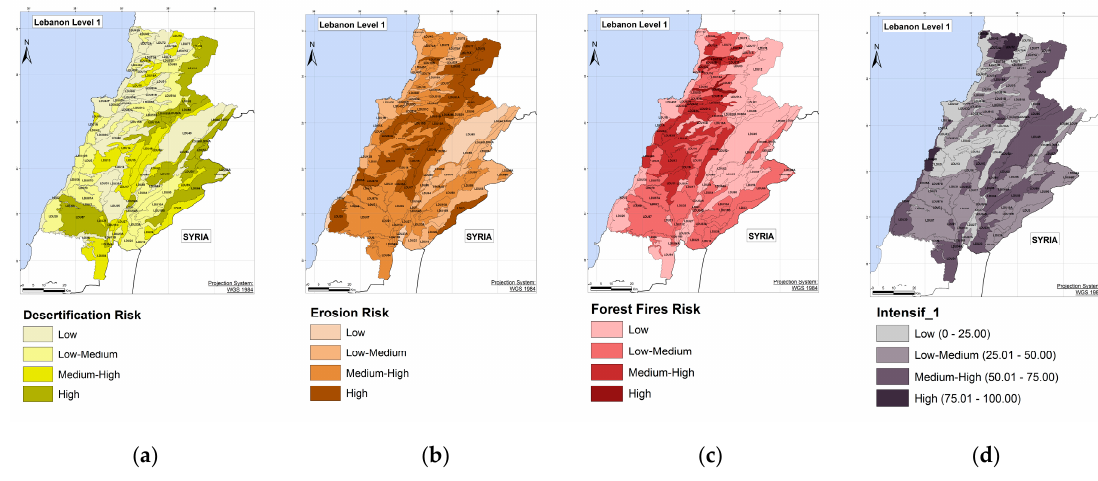
Figure 11. Hazard Maps for LDU’s of Desertification (left), Erosion (middle), and Intensification of urban sprawl (right) in Jordan: Al-Yarmuk ( a – c ) and Mujib ( d – f ). Land 2017 , 6 , x FOR PEER REVIEW